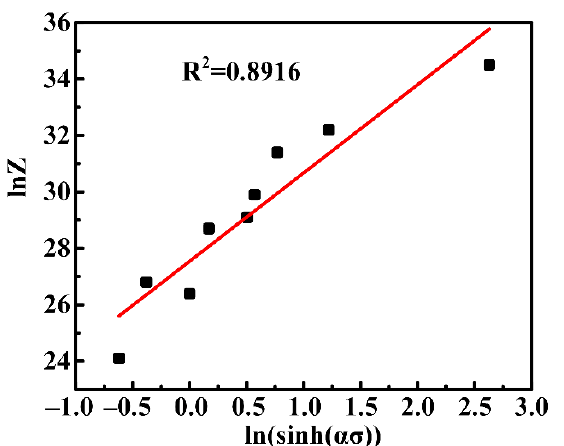
Figure 5. Relationship between the Zenner–Hollomon parameter (ln Z ) and ln [ sinh ( ασ )] .